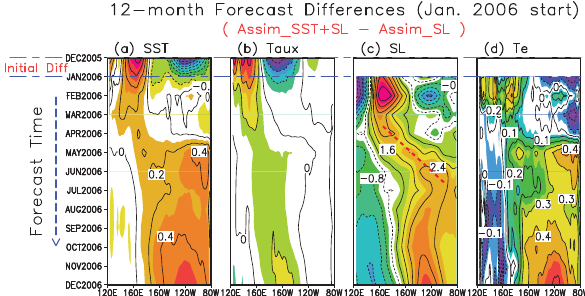
Figure 3. Initial and forecasted differences between the As- sim_SST + SL hindcast and the Assim_SL hindcast for (a) SST, (b) zonal τ x , (c) SL, and (d) T e , illustrating the effects of the ini- tial surface states, SST and τ on predicting the 2006–2007 El Niño event. The dashed red line in (c) represents the propagation of the downwelling Kelvin wave. The contour interval is 0.2 ◦ C in (a) , 0.08dyncm − 2 in (b) , 0.8 cm in (c) , and 0.1 ◦ C in (d ). The initial differences in December 2005 for the surface states (SST and τ ) are demonstrated in the left two